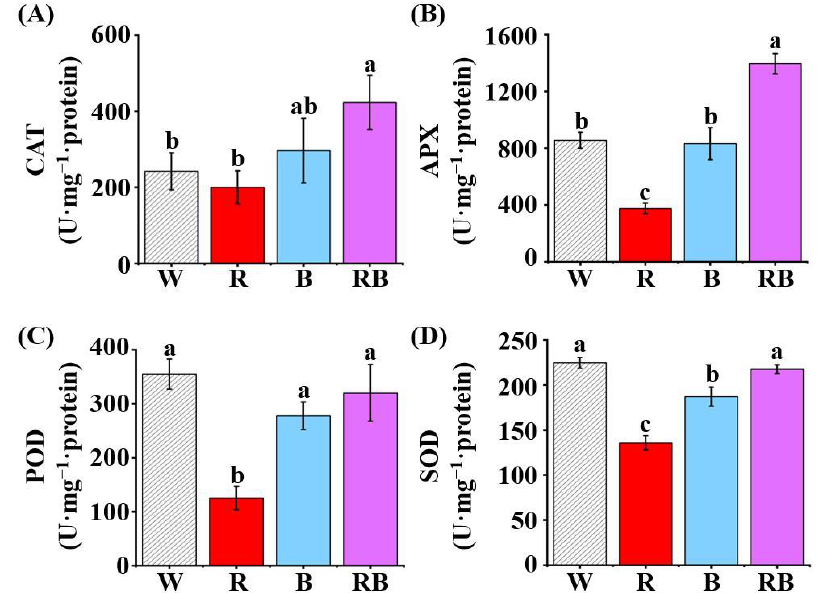
Figure 7. Effect of light quality on activities of catalase (CAT) ( A ), ascorbate peroxidase APX ( B ), peroxidase (POD) ( C ), and superoxide dismutase (SOD) ( D ) in leaves of C. triste plantlets after four weeks of culture: The light qualities used were W, white LED; R, red LED; B, blue LED; and RB, combined red and blue LEDs in a 1:1 ratio. The results were expressed as means ± standard errors ( n = 3). Different letters indicate significant differences ( p < 0.05) by the Tukey’s multiple range test.